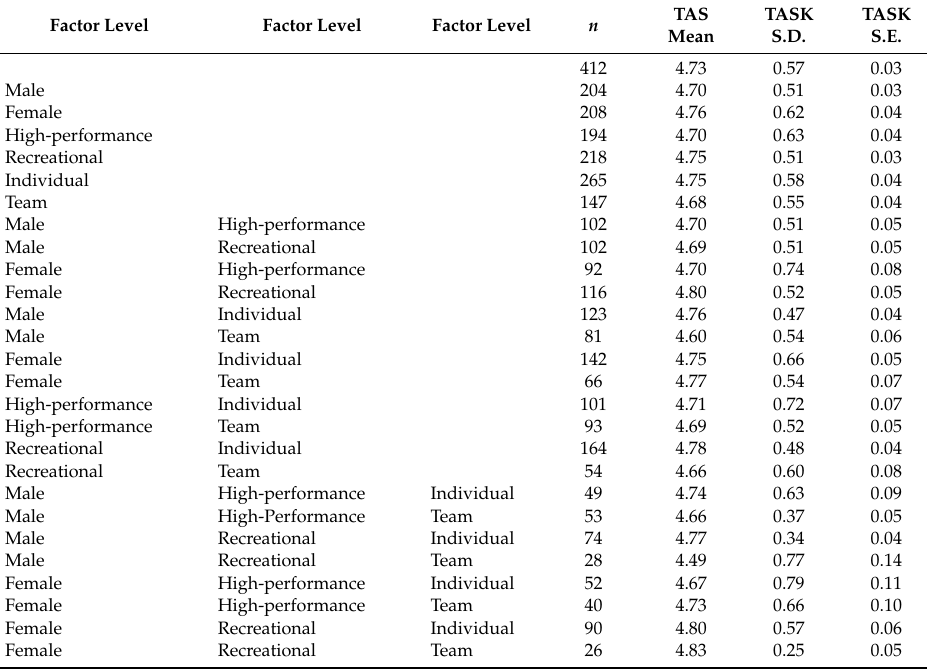
Table 8. Descriptive statistics for task